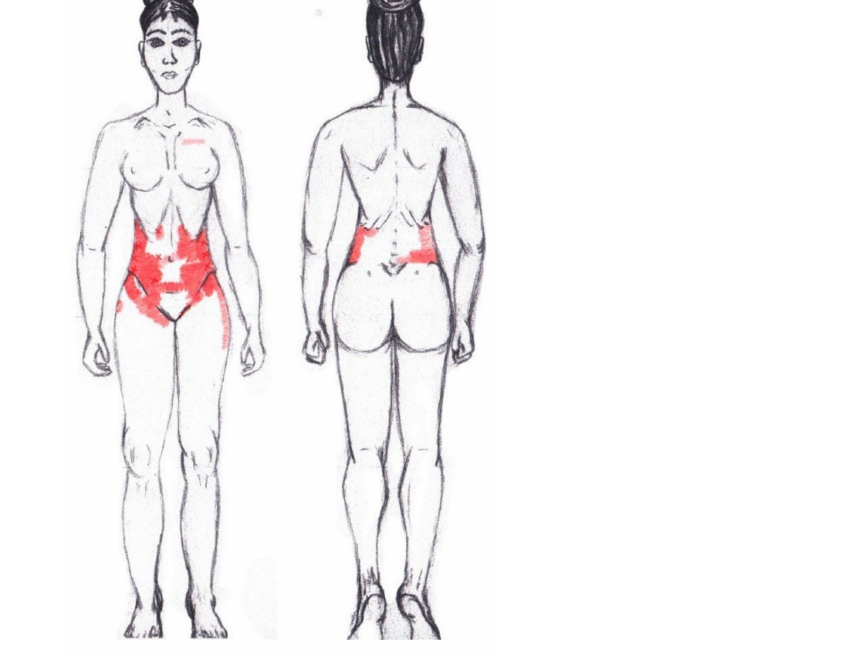
Figure 5. Graphical simulation of referred pain areas of the external oblique muscle.